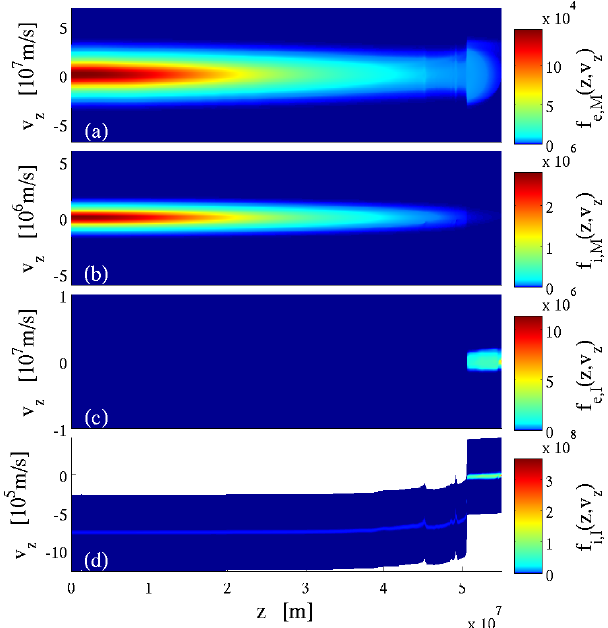
Fig. 5. Phase space densities f (z,v z ) at t = 5 . 0s for (a) magneto- spheric electrons; (b) magnetospheric protons; (c) ionospheric elec- trons; and (d) ionospheric protons. The colour scales have been nor- malised so that integrals over all v z yield n s /B . In panel (d) , the simulated velocity range is allowed to shift so that, for each value of z , it is centred on the mean velocity. Thus, large unpopulated phase space regions (white in this figure) do not need to be